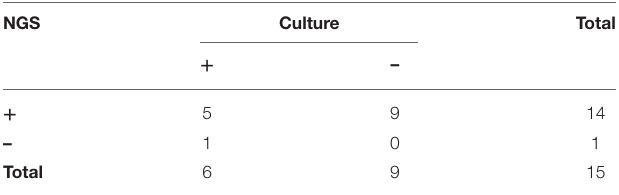
TABLE 4 | Comparison of next-generation sequencing (NGS) and traditional culture analyses in TM infection.